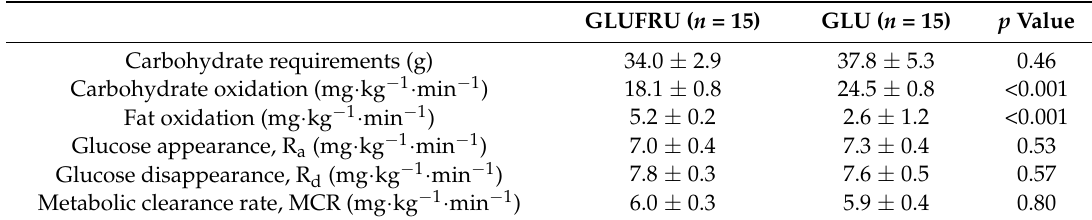
Table 2. Metabolic measures during last 30 min of exercise in GLUFRU and GLU. Values are mean (SEM). GLUFRU = glucose-fructose co-ingestion, GLU = glucose alone